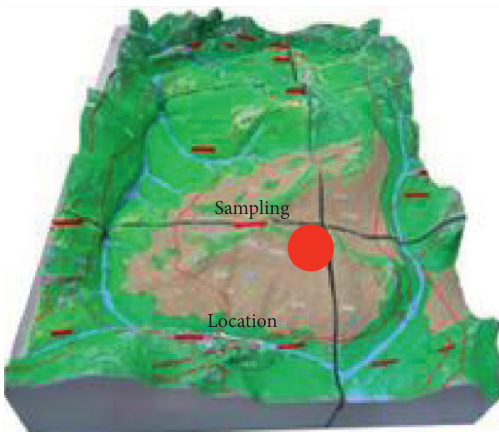
Figure 1: Sampling site of deep sandstone